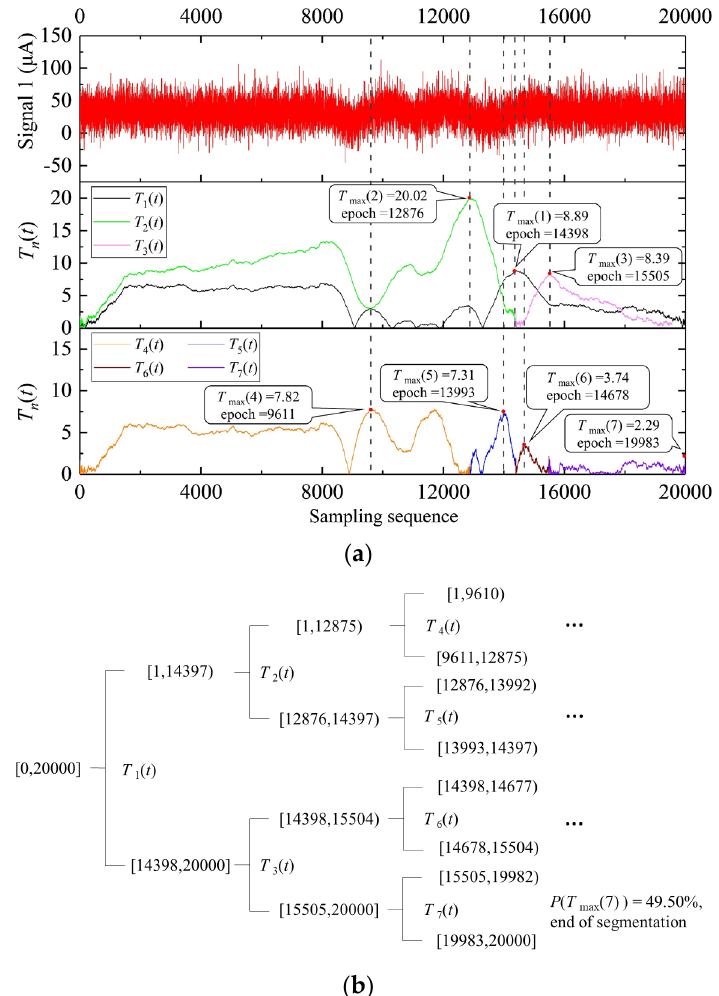
Figure 4. First seven segmentation processes of signal 1 using the HSA-KS method: ( a ) time series of signal 1 and the first seven T i ( t ); ( b ) dendrogram of the segmentation processes.